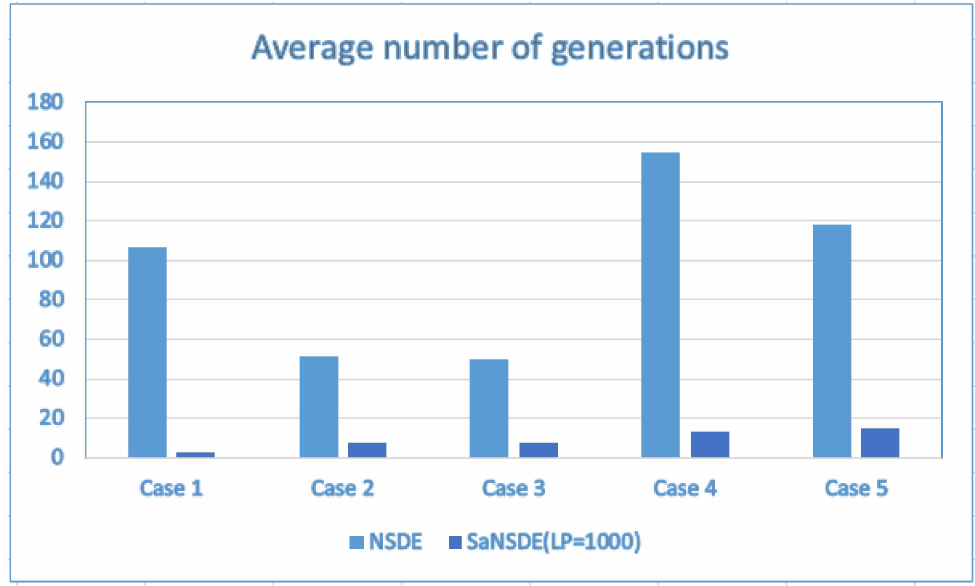
Figure 7. The average number of generations obtained by NSDE and SaNSDE with LP = 1000 for Case 1, Case 2, Case 3, Case 4 and Case 5.